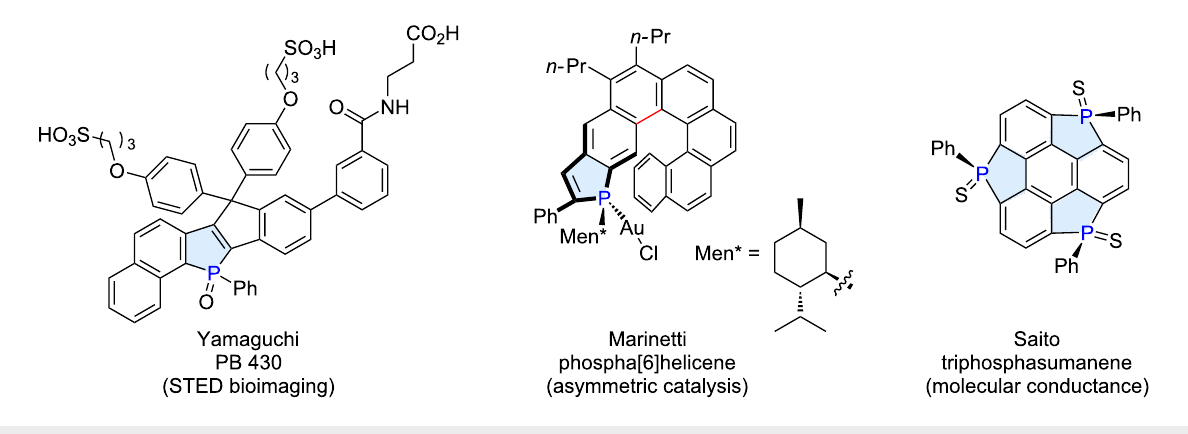
Figure 1: Examples of functional molecules based on π -extended phospholes.